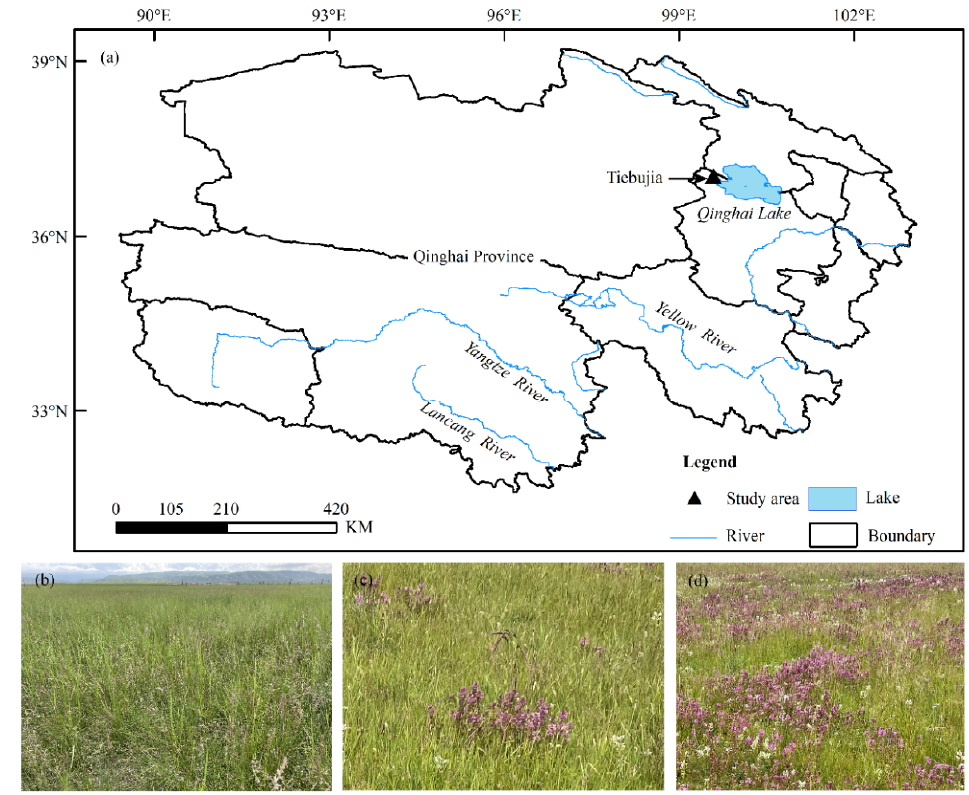
Figure 1. Location of the study site in Qinghai province ( a ), control plot patch (CK) ( b ), low density patch (LD) ( c ), and high density patch (HD) ( d ).